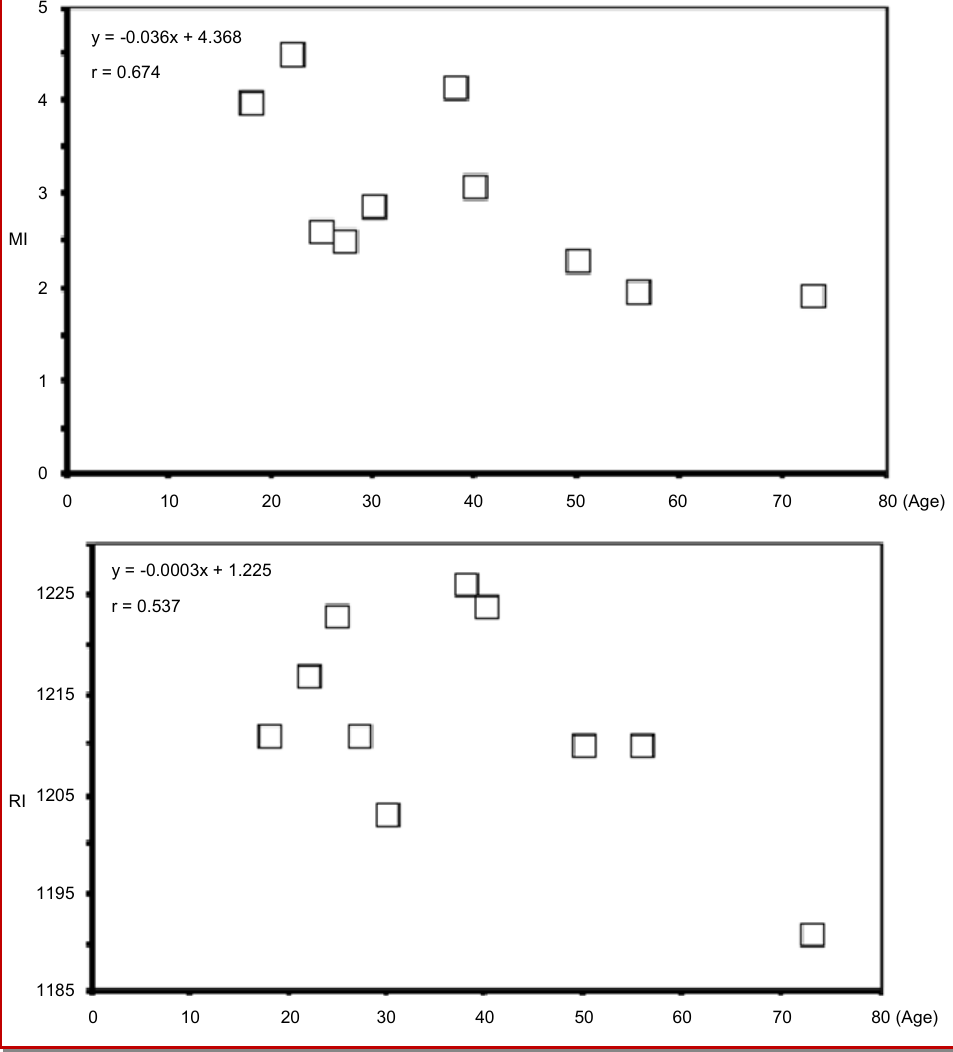
Figure 3: The negative correlations between mitotic index and age, replication index and